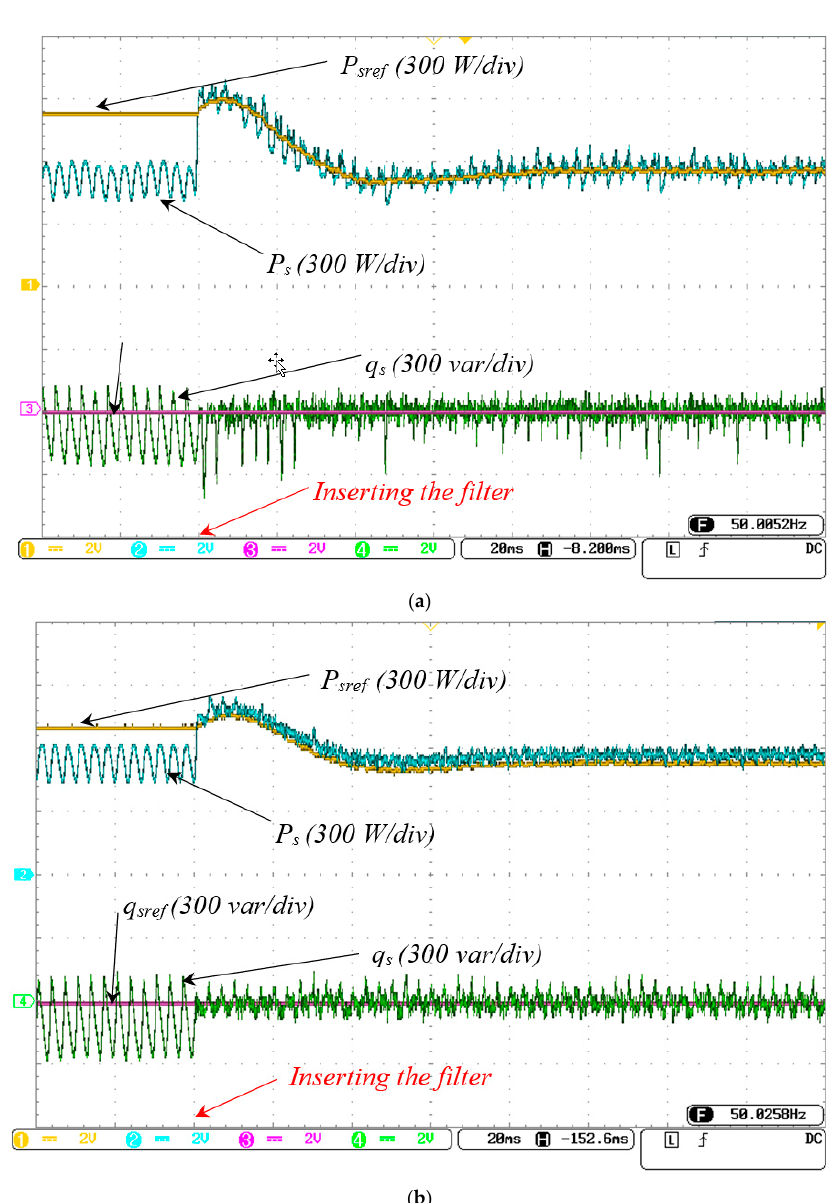
Figure 14. Active and reactive powers of the main source at filter insertion by using conventional DPC ( a ) and MPPC-SVM ( b